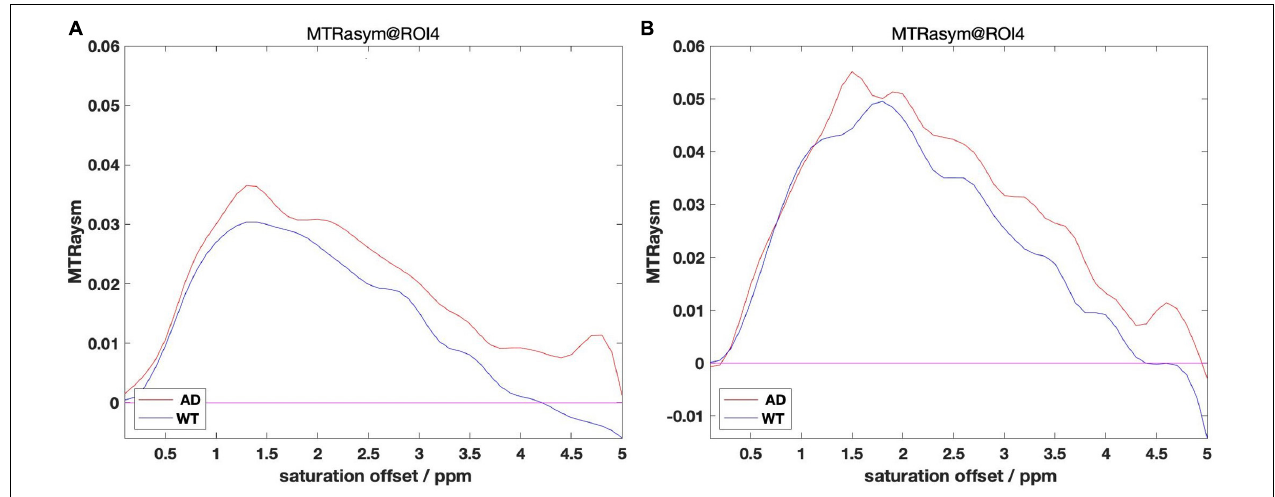
FIGURE 3 | (A) MTRasym within 4 month group. (B) MTRasym within 12 month group. Comparisons between group AD and WT of 4 m (A) and 12 m (B)